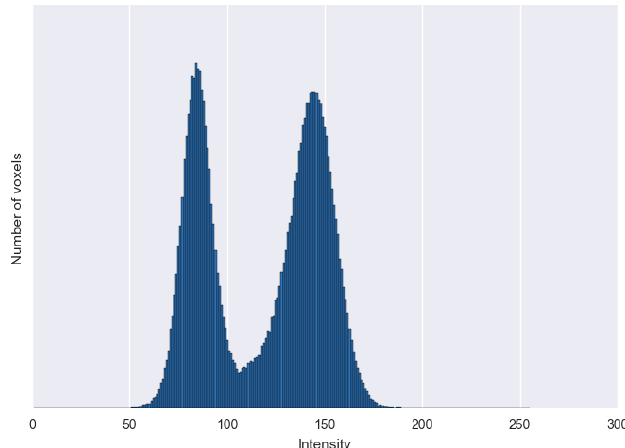
Figure 5. Histogram of intensities of a central fragment of grayscale image G.